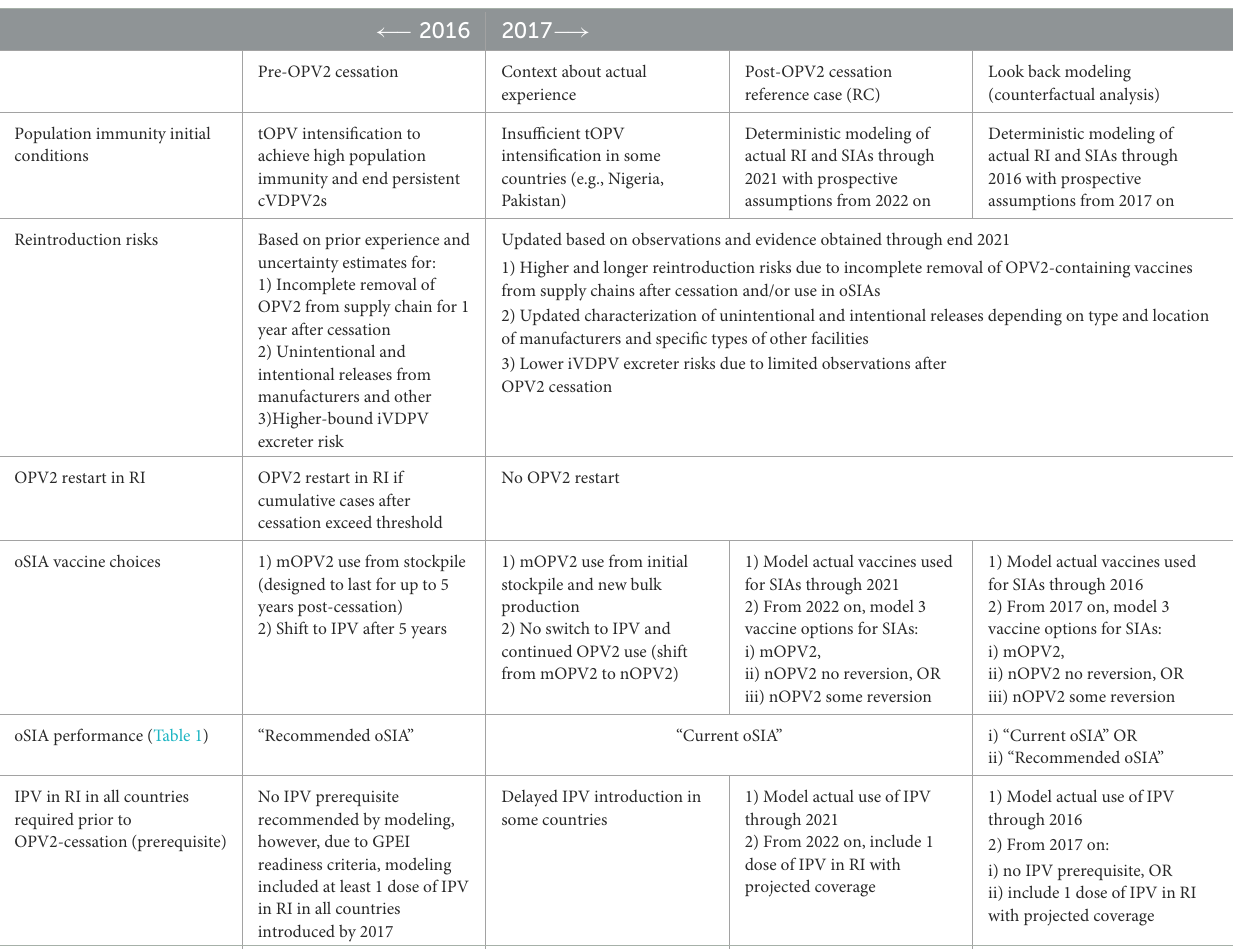
TABLE 2 Overview of conditions and assumptions for prospective modeling studies performed pre- and post-OPV2 cessation, actual observations that motivated post-OPV2 cessation modeling changes, and alternative scenarios considered in this look back